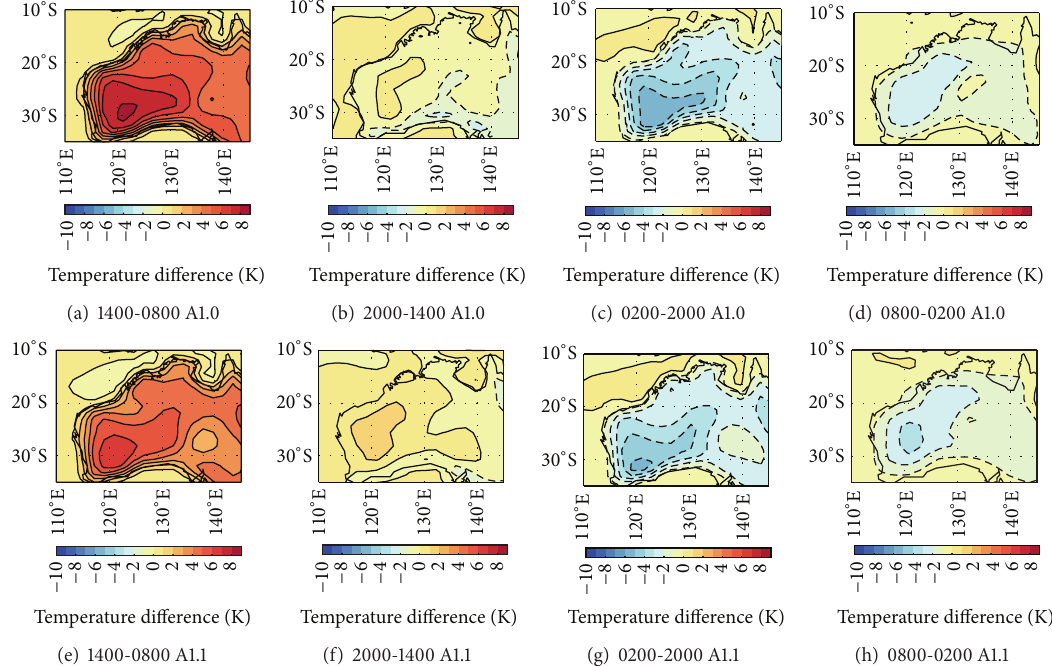
Figure 7: The difference in air temperature (K) at 925 hPa between (a and e) 1400 and 0800, (b and f) 2000 and 1400, (c and g) 0200 and 2000, and (d and h) 0800 and 0200. (a)–(d) are from A1.0 and (e–h) are from A1.1.